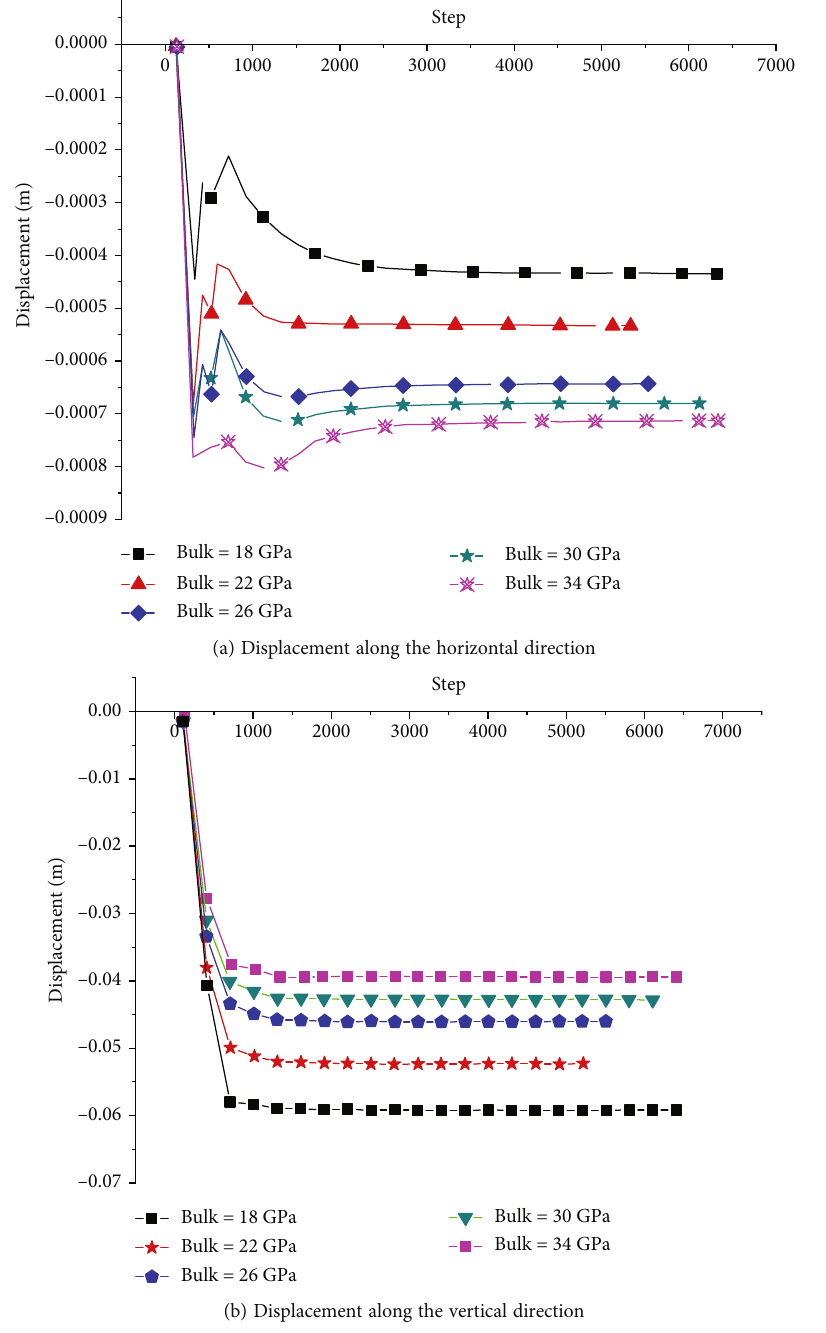
Figure 9: Displacement magnitude under the condition that the bulk modulus